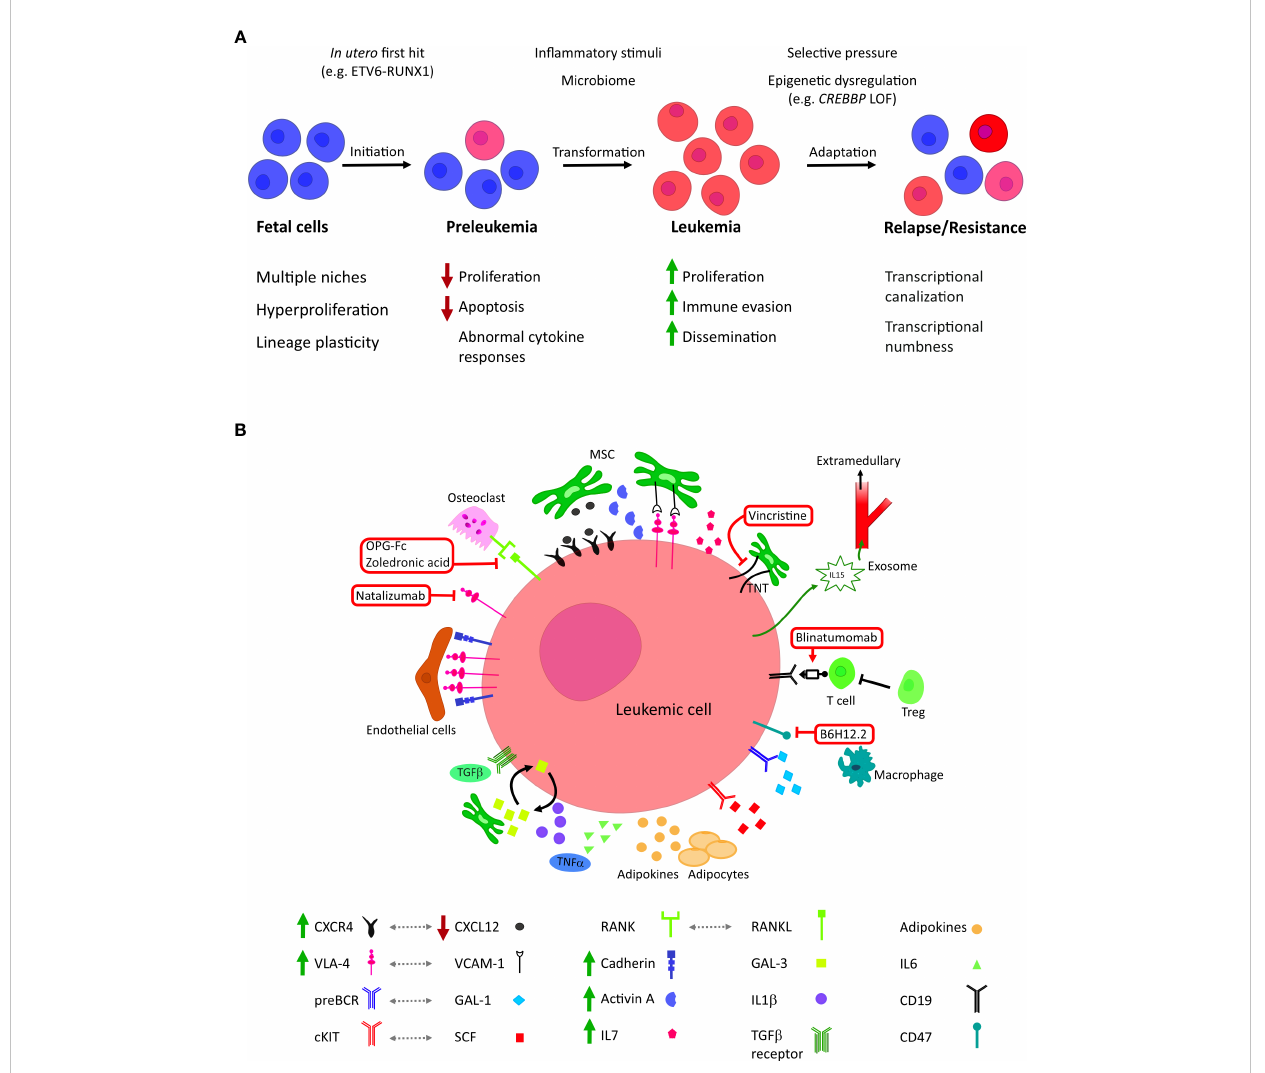
FIGURE 1 (A) The roles of microenvironmental factors at different stages of tumor evolution in childhood BCP-ALL. BCP-ALL is thought to initiate in utero where B lineage progenitors exhibit unique characteristics, including inhabiting diverse niches. First-hit mutations create a clinically silent preleukemic state that persists into childhood. In a small number of children, this pre leukemic state transforms to acute leukemia; this is thought to be driven by the acquisition of co-operative second hit mutations, possibly in response to in fl ammatory signaling. Leukemic blasts evolve to colonize further niches and evade treatment, altering their epigenetic state to become less dependent on external stimuli. (B) Cellular and molecular microenvironmental factors associated with BCP-ALL. Current and investigational therapeutic targets are highlighted in red: mitochondrial transfer through tunnelling nanotubules (TNT) can be inhibited by the microtubule inhibitor vincristine; blinatumomab co-associates B-lineage blasts with tumour-targeting cytotoxic T cells; neutralization of CD47 by B6H12.2 antibody restores the macrophage phagocytic response against leukemic blasts; zoledronic acid and recombinant OPG-Fc reduce bone loss, inhibiting leukemic growth and prolonging survival in vivo ; integrin 4 inhibitor Natalizumab sensitizes leukemic blasts to